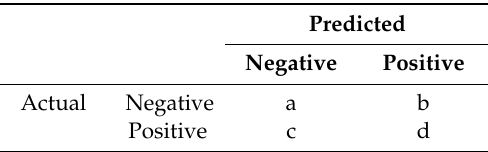
Table 3. The principle of the error